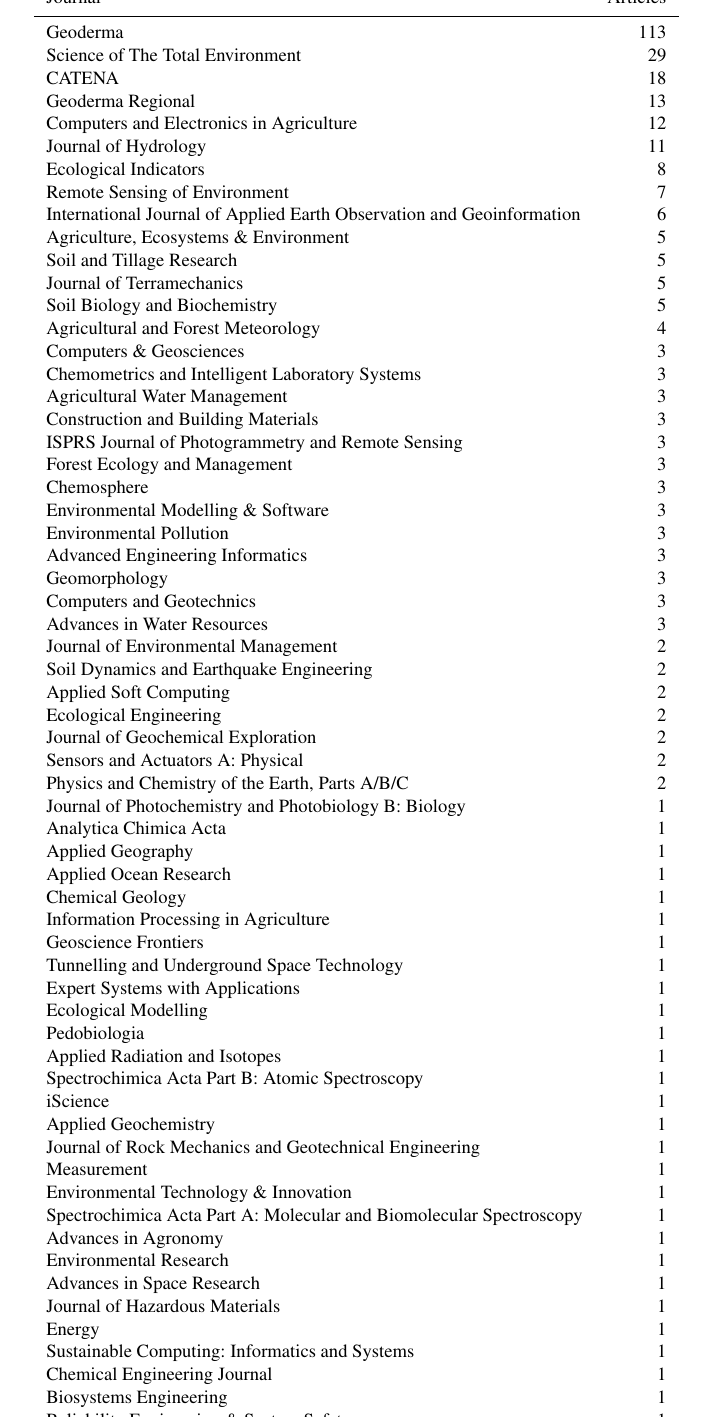
Table A1. List of journals by publisher and number of articles that matched the term “soil ‘machine learning”’ in a full-text